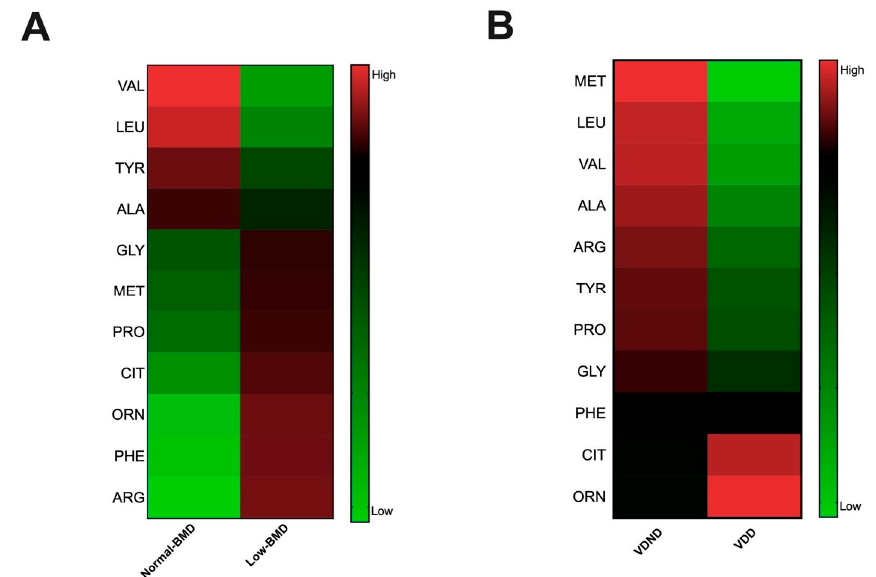
Figure 5. Association between serum metabolites with bone mineral density and vitamin D deficiency. ( A ) Amino acid concentration heatmap in each group; red and green indicate an increased and decreased concentration, respectively; the low-BMD group had a lower valine and leucine concentration than the normal-BMD group. ( B ) Amino acid concentration heatmap in each group, red and green indicate increase and decreased concentration, respectively. Postmenopausal no vitamin D-deficient women (VDND) had higher serum concentrations of valine and leucine, tyrosine, alanine, and proline than postmenopausal vitamin D-deficient women (VDD).